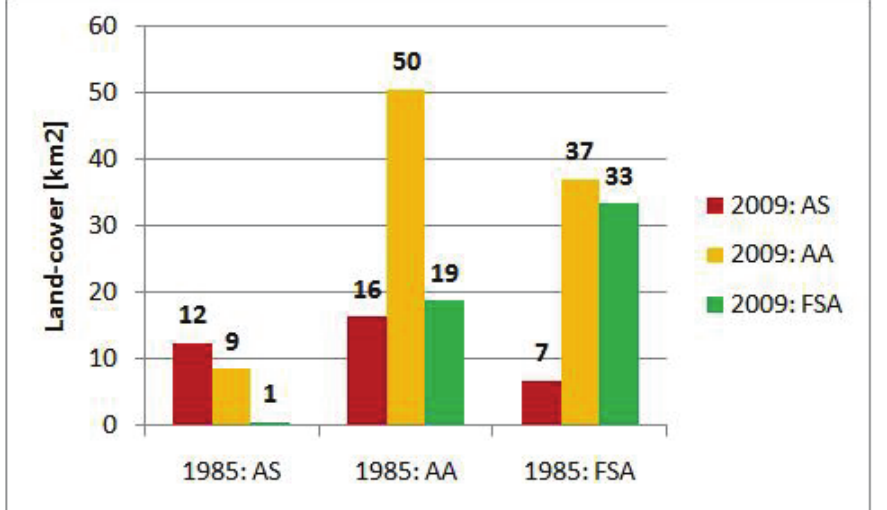
Figure 4. Land-cover changes in AOI as a result of large-scale mining 1985–2009 (km 2